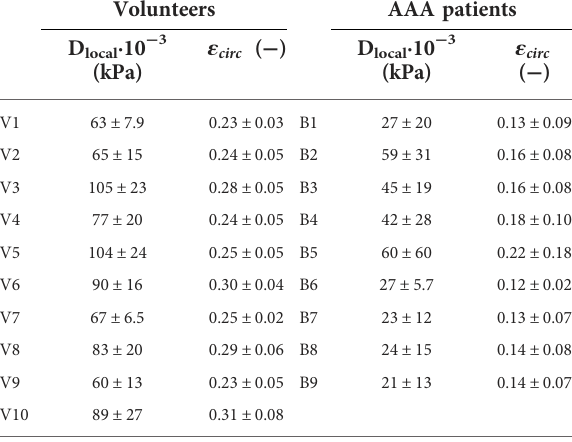
TABLE 3 Overview of mean local distensibility, D local , and mean local circumferential strain, 1 circ , of healthy volunteers (V1 – V10) and AAA patients (B1 – B9).